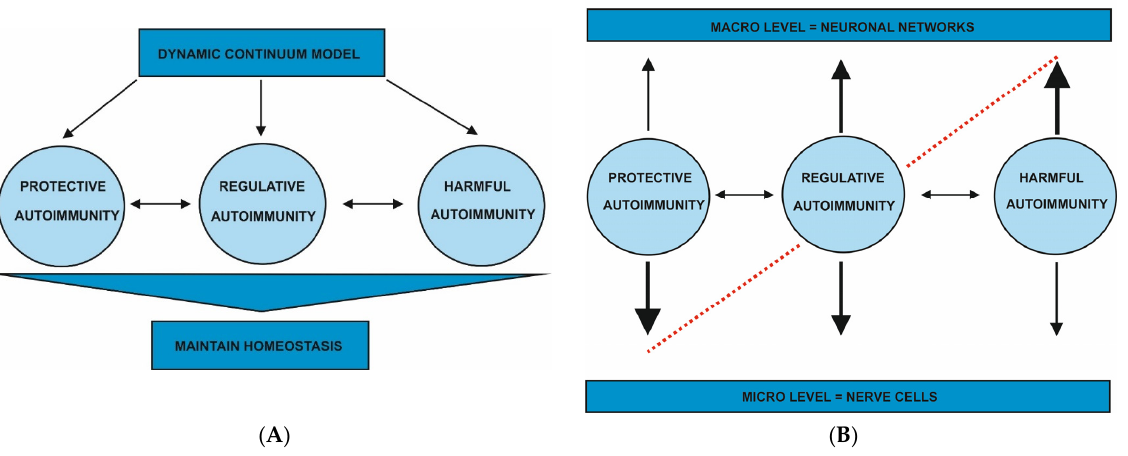
Figure 1. ( A ) Dynamic continuum model of autoimmunity. The dynamic continuum model of autoimmunity is depicted in Figure 1, and ranges from protective and regulatory to harmful forms of autoimmunity, which all serve to maintain brain homeostasis and thus mental health. ( B ) Dynamic continuum model of autoimmunity categorized into neuronal systems. The neuronal systems that are affected by the postulated three types of autoimmunity are the nerve cell on a micro level and neuronal networks on a macro level. Each type of autoimmunity differently affects these neuronal systems, so that a shift more affecting a micro level in protective autoimmunity can have an effect on the macro level with more consequences of harmful autoimmunity for neuronal networks can be observed (multi-systemic dynamic continuum model). The dashed line represents potential imbalance if one form of autoimmunity increases. For example, when harmful autoimmunity increases, protective autoimmunity decreases. When regulatory autoimmunity predominates, harmful and protective autoimmunity are equal. The increase in one form of autoimmunity is additionally indicated by the arrow’s size: a larger arrow indicates this form of autoimmunity’s predominance.